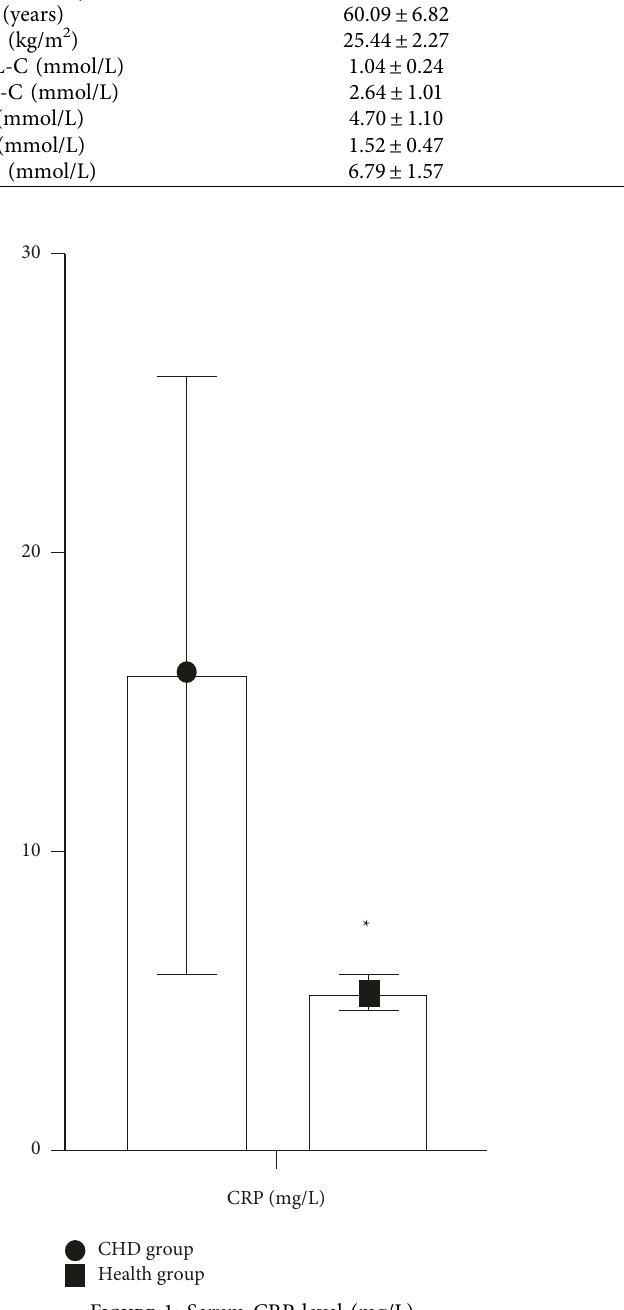
Figure 2: Serum IL-6 level ( μ g/L).